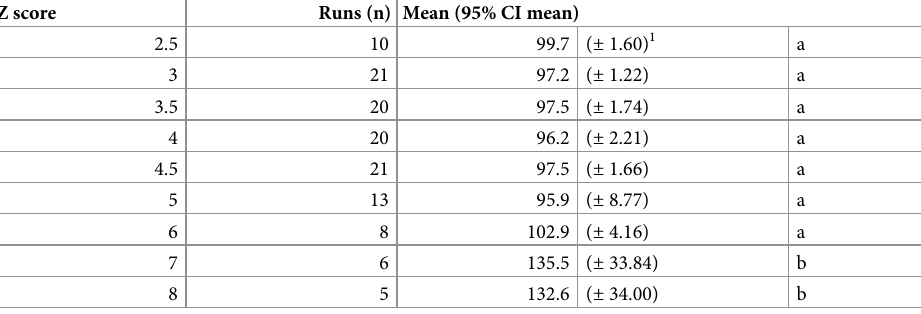
Table 1. Summary data of the effect of Z score on the number dispensed when 100 was